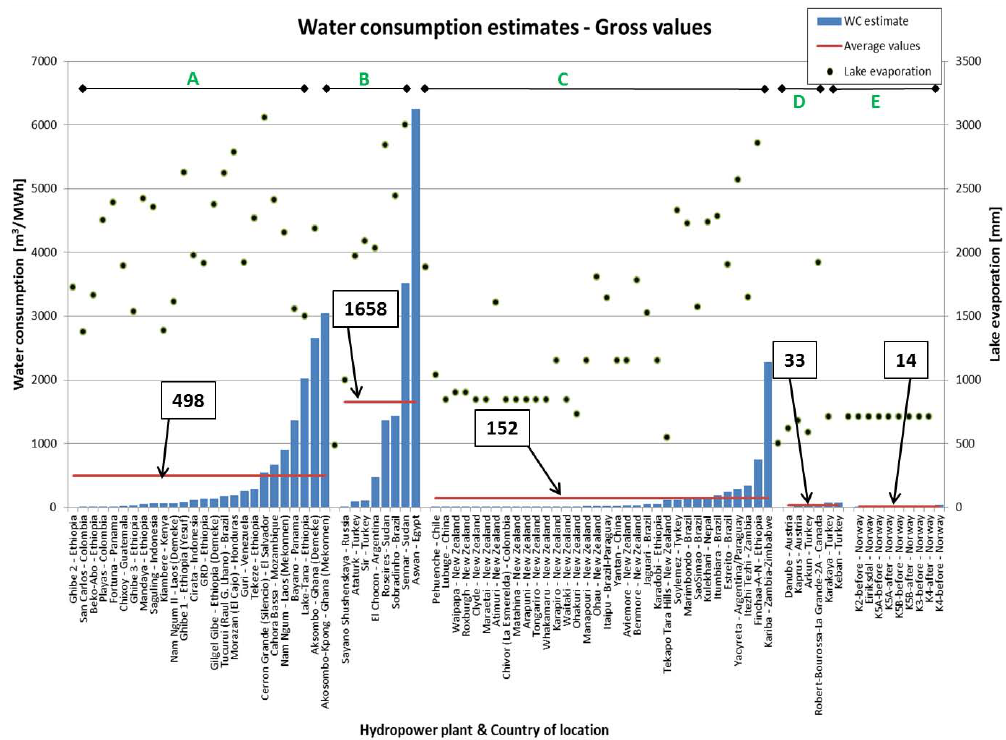
Fig. 1. The figure presents gross water consumption estimates and evaporation rates for the individual plants. The horizontal lines with number tags attached are average water consumption (arithmetic averages) values for the climate zones according to the classification given by Köppen–Geiger (Köppen, 1936). The codes of the 5 climate zones are given in red. The “before” and “after” annotation to the Norwegian data refers to before and after refurbishment of the hydropower system.